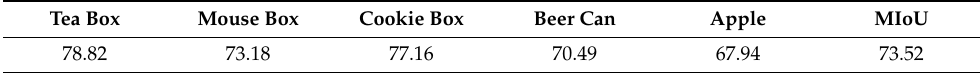
Table 2. Dataset IOU calculation results (%).